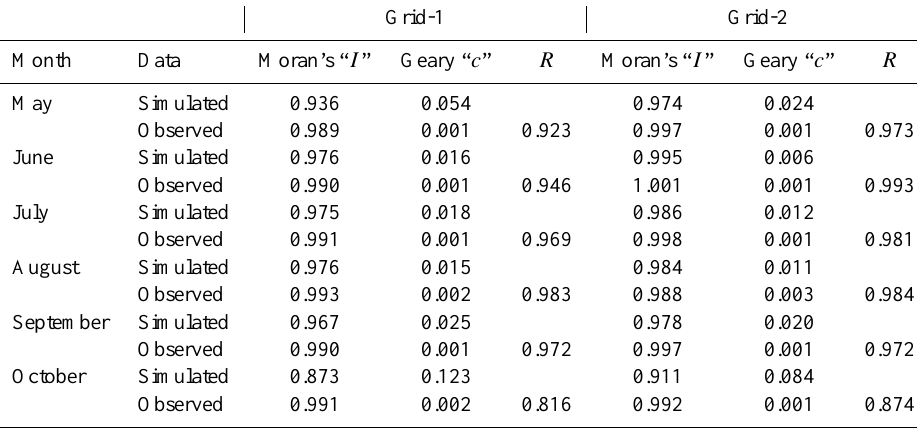
Table 3. Spatial statistics of observed and simulated data relative to adjacent cells.